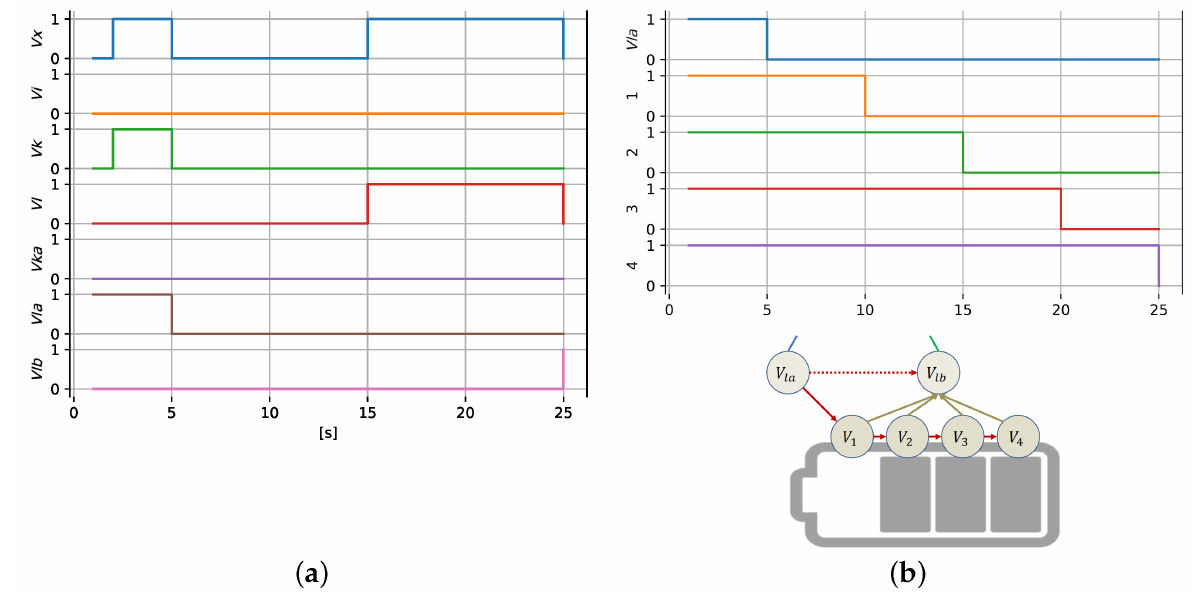
Figure 5. ( a ) Example scenario of redundant node failure and activation. ( b ) Model expansion in the case of resource discretization into